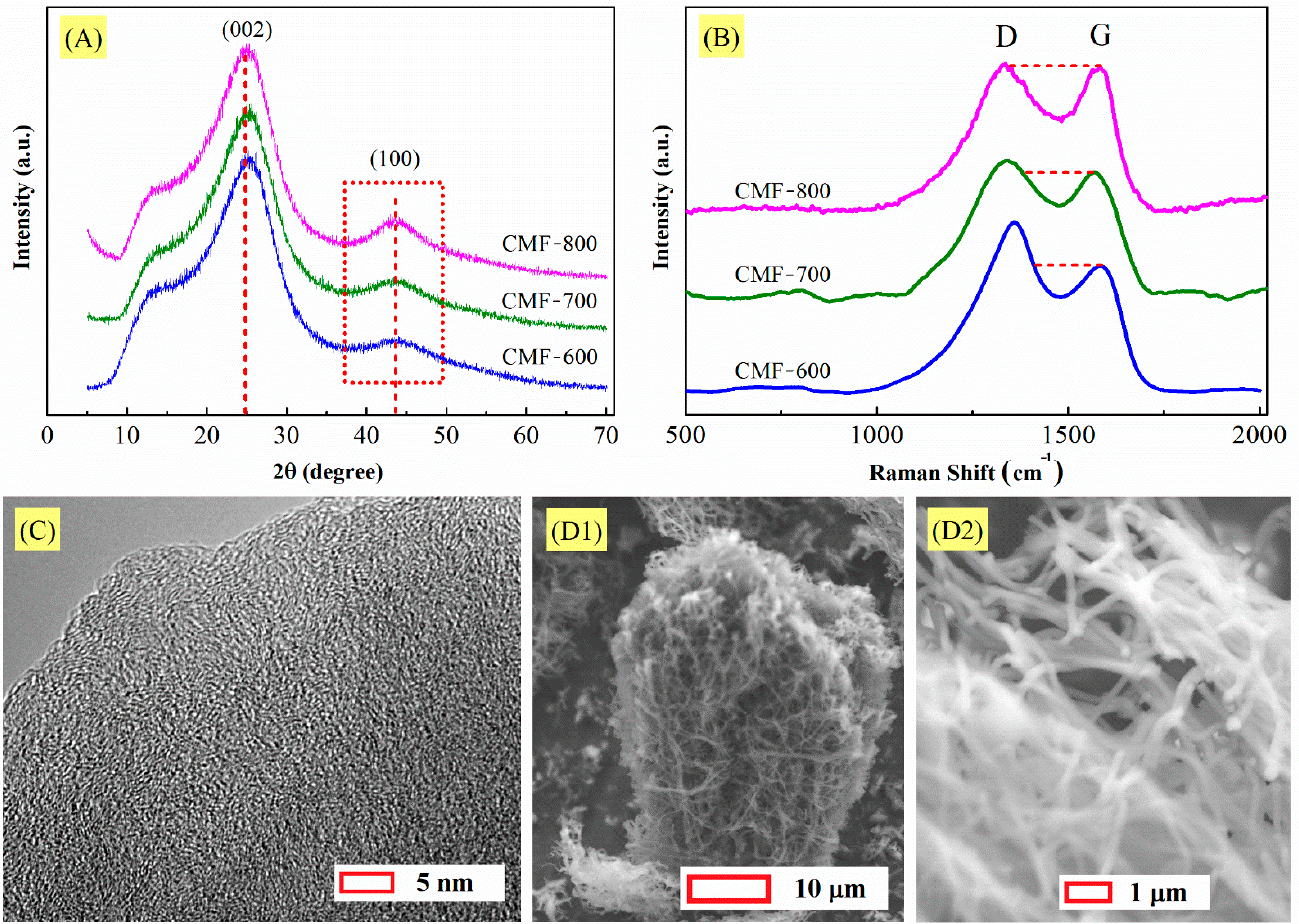
Figure 4. ( A ) XRD pattern and ( B ) Raman spectra for CMFs, “adapted from [13]”. ( C ) TEM and ( D1 ), ( D2 ) SEM micrographs of CMF-800. Table 1. Structural and chemical properties of CMFs.